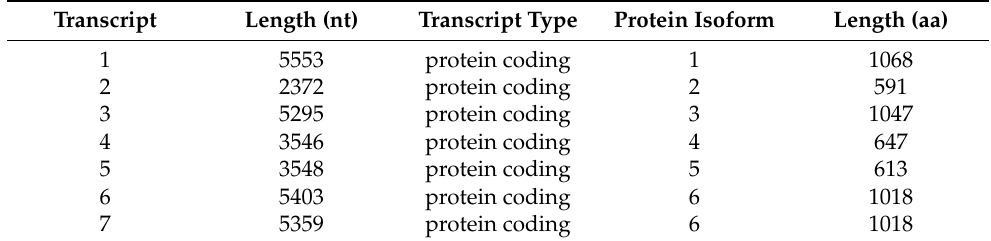
Table 2. Transcripts and proteins coded by the RIPOR2 gene.